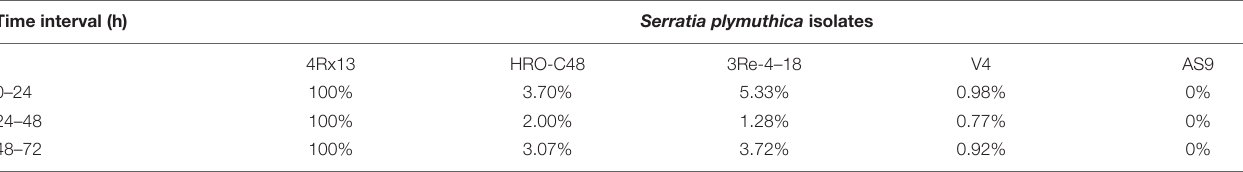
TABLE 1 | Relative sodorifen emissions in Serratia plymuthica